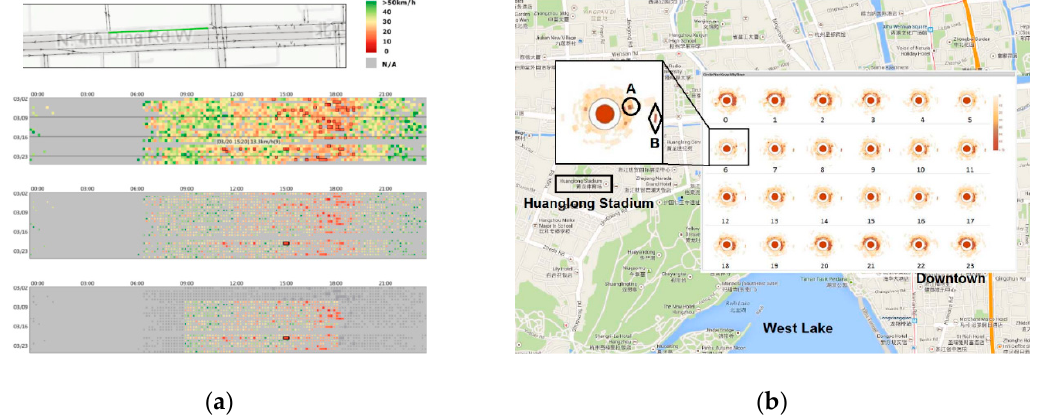
Figure 34. Examples of pixmap visualization : ( a ) tabular pixmaps for speed-pattern exploration [84]; and ( b ) 24-hour taxi-trajectory patterns [85].